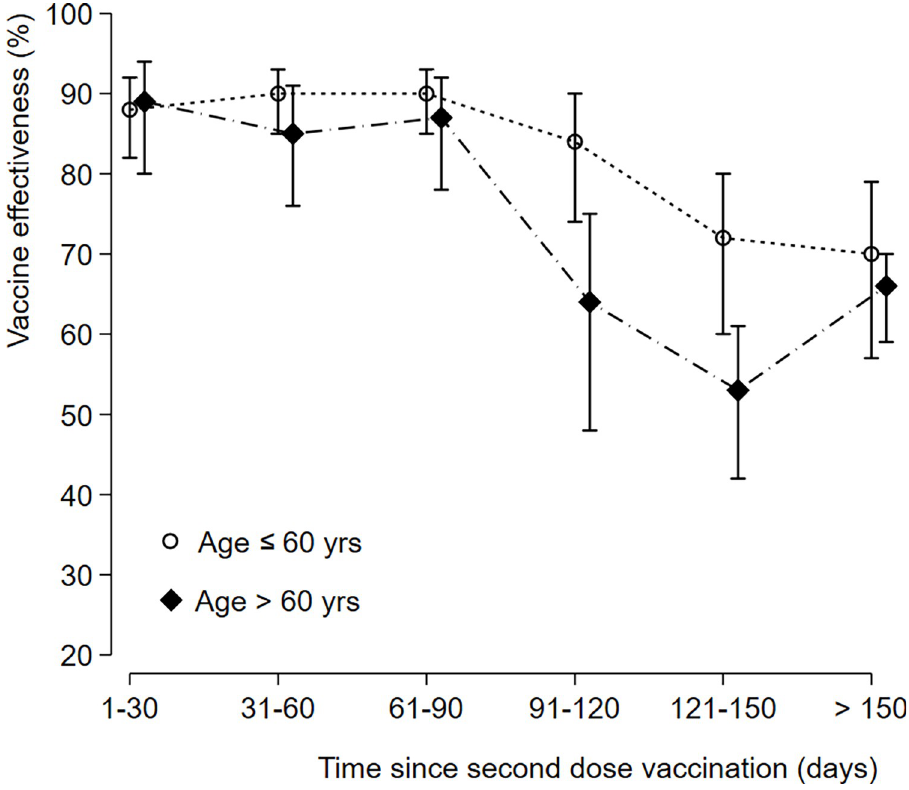
Fig 3. Vaccine effectiveness of inactivated vaccine BBIBP-CorV against COVID-19-associated severe or critical hospitalization over time since second dose vaccination according to age subgroup. Vaccine Effectiveness at each Time Point in age subgroup � 60 years old: VE at (1–30) time point; 80% (95% CI: 80–94).VE at (31–60) time point; 85% (95% CI: 76–91). VE at (61–90) time point; 87% (95% CI: 78–92). VE at (91–120) time point; 64% (95% CI: 48– 75). VE at (121–150) time point; 53% (95% CI: 42–61). VE Beyond 150 days’ time point; 66% (95% CI: 59–70). Vaccine Effectiveness at each time point in age subgroup < 60 years old: VE at (1–30) time point; 88% (95% CI: 82–92). VE at (31–60) time point; 90% (95% CI: 85–93). VE at (61–90) time point; 90% (95% CI: 85–93). VE at (91–120) time point; 84% (95% CI: 74–90). VE at (121–150) time point; 72% (95% CI: 60–80). VE Beyond 150 days’ time point; 70% (95% CI: